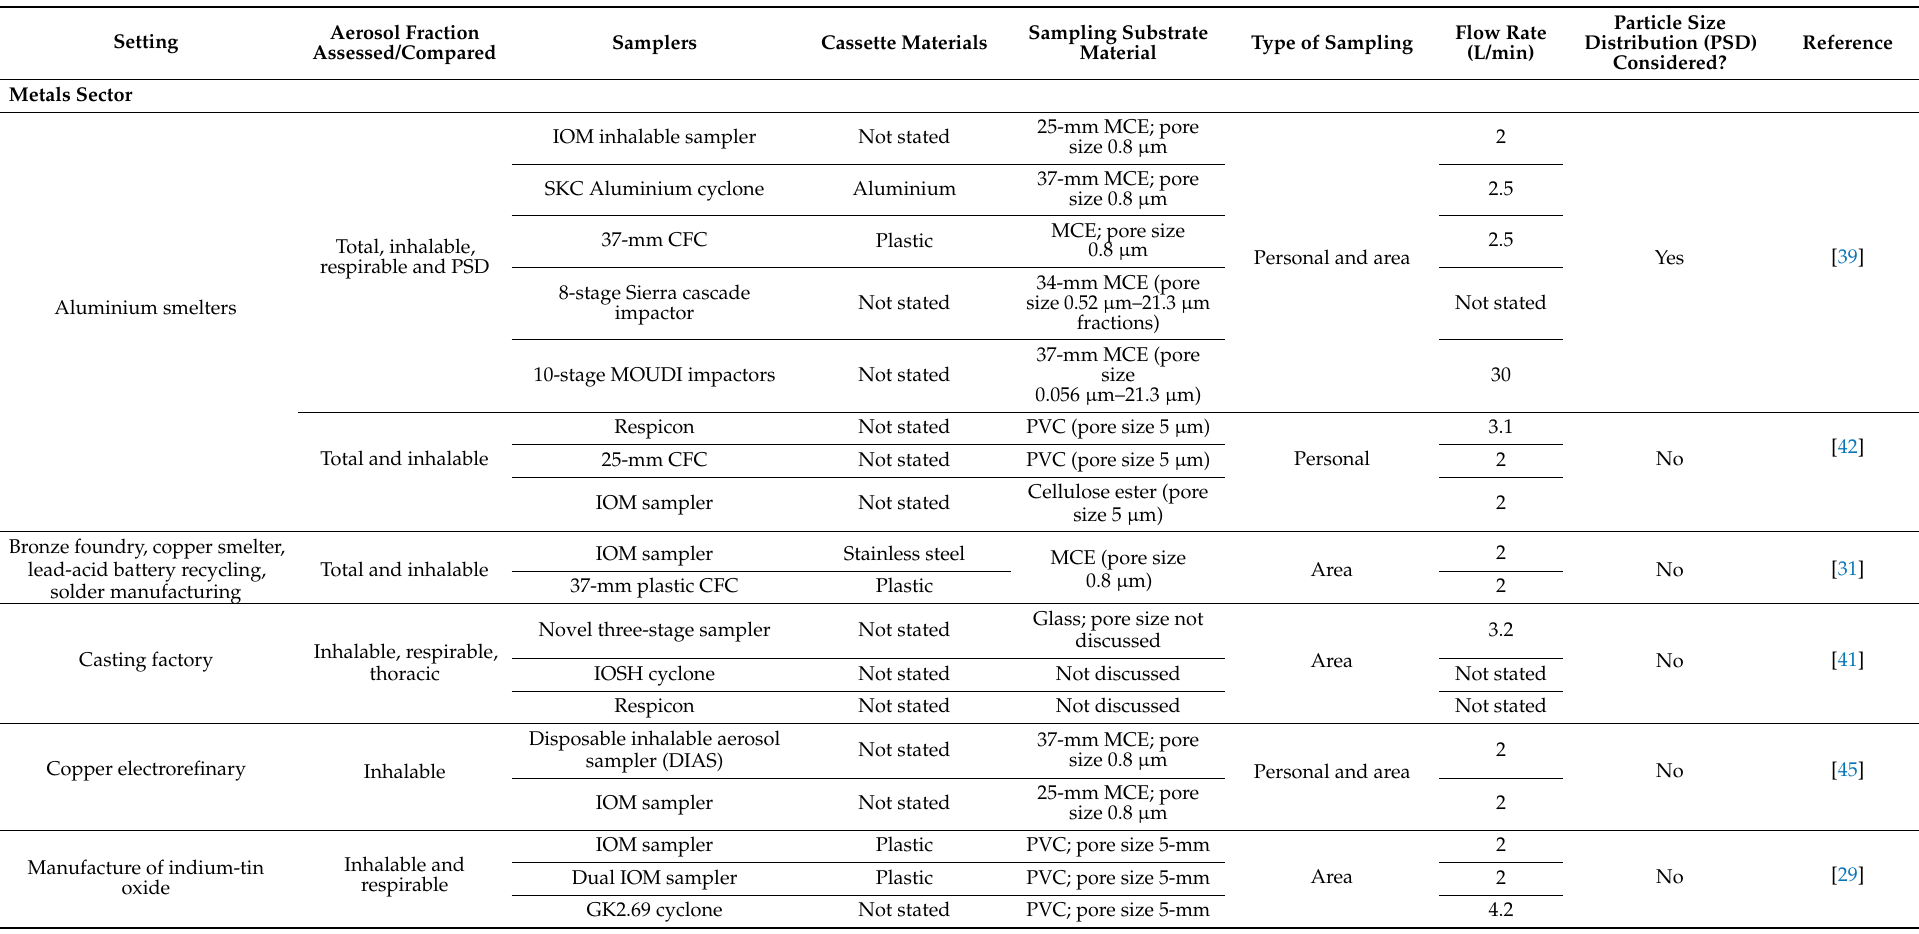
Table A2. Workplace based sampler comparison article